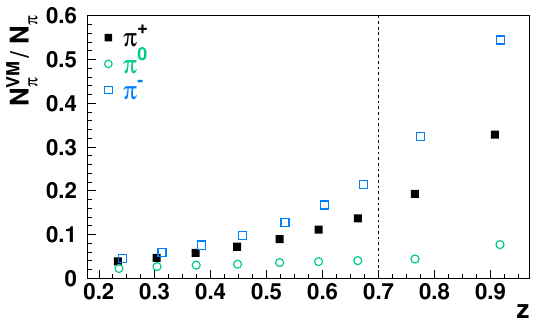
Figure 4 . The simulated fraction of pions originating from diffractive vector-meson production and decay is shown as a function of z . (The open squares indicating π − are slightly shifted horizontally). The contributions are simulated by a version of Pythia6.2 [96, 97] tuned for HERMES kinematics. By limiting z to z < 0 . 7 , a kinematic region is probed where the vector-meson contribution to the electroproduction of pions is suppressed, in particular for charged pions. For charged kaons, the contribution from φ decay is at maximum 10%